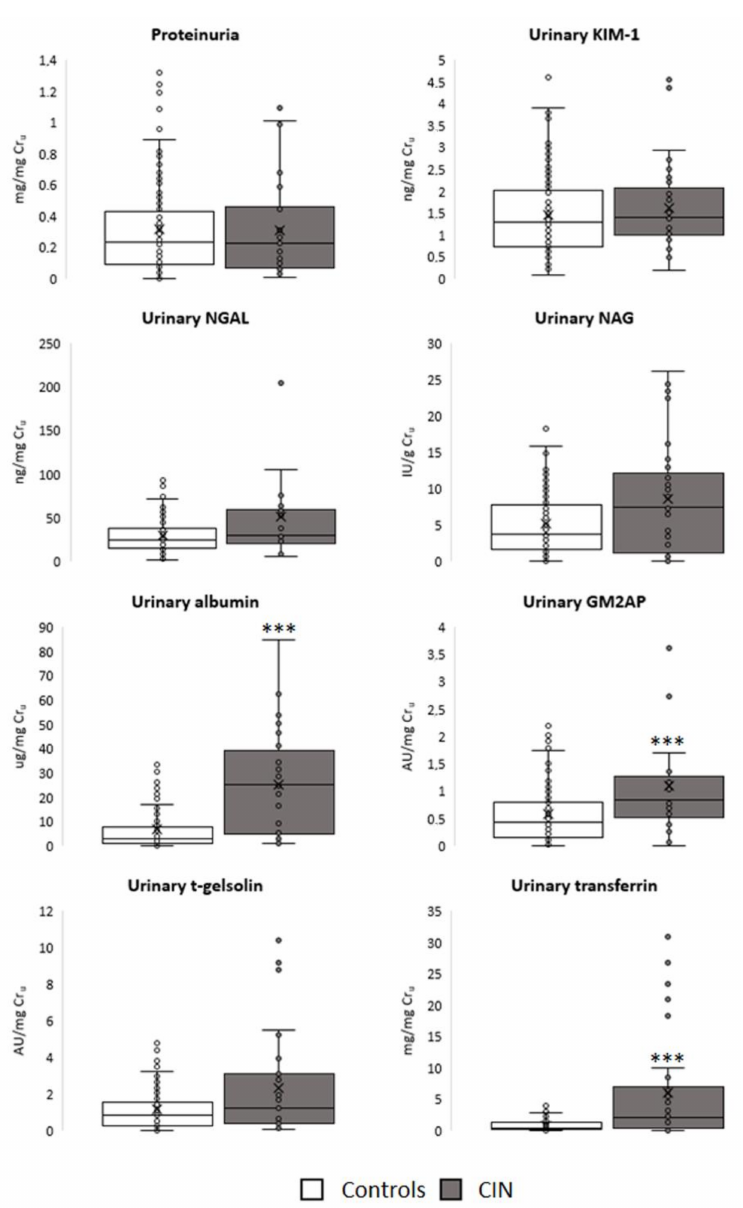
Figure 1. Urinary excretion of the biomarkers evaluated in the study groups before contrast media administration. Data are presented as box plots. *** p < 0.001 vs. Controls. AU: arbitrary units; CIN: contrast-induced nephropathy; Cr u : urinary creatinine; GM2AP: GM2 ganglioside activator protein; IU: International Units; KIM-1: kidney injury molecule-1; NAG: N -acetyl- β - D -glucosaminidase; NGAL: neutrophil gelatinase-associated